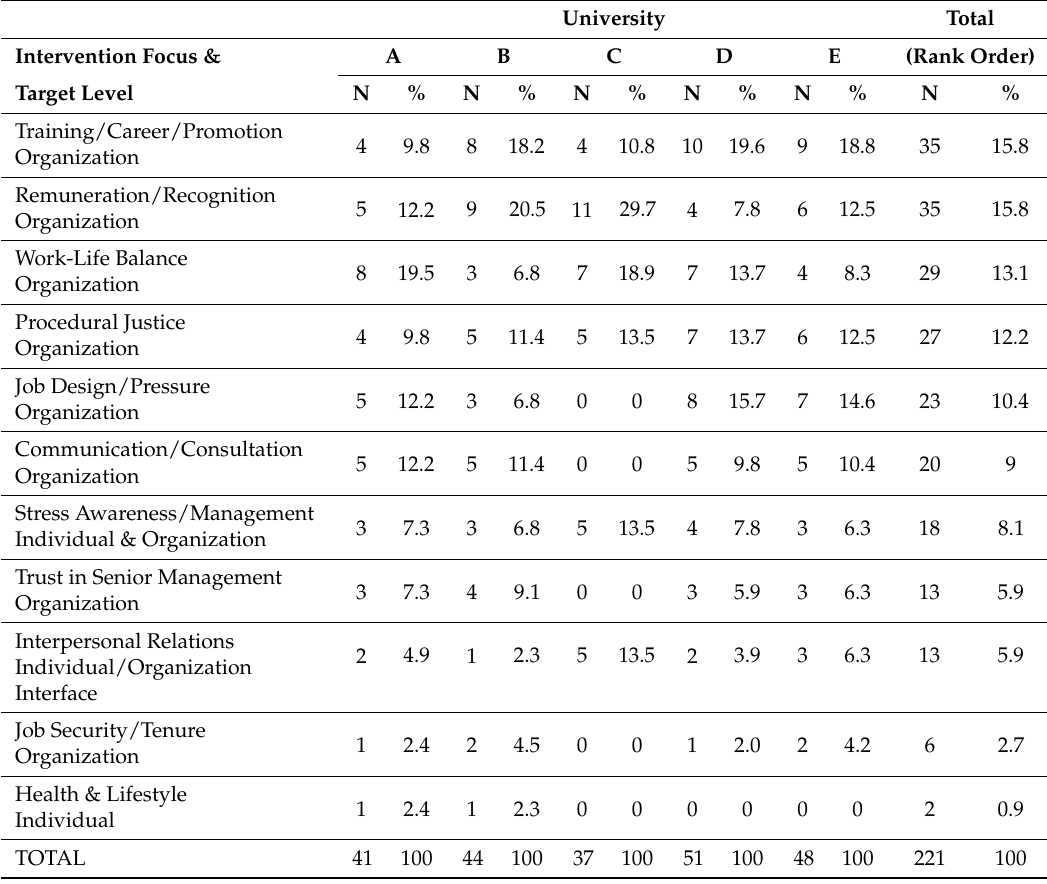
Table 1. Number and Type of Strategies Implemented and their Target Level.